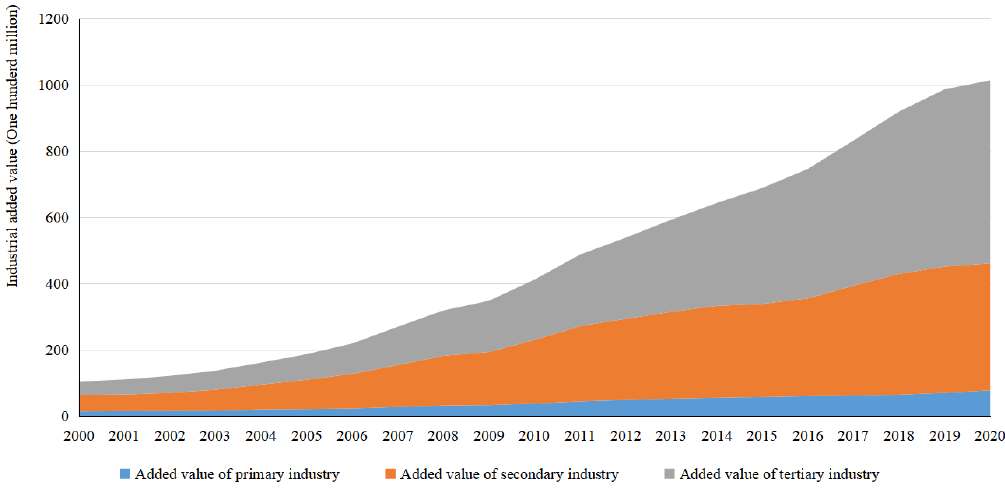
Figure 2. China’ s added value of various industries from 2000 to 2020.